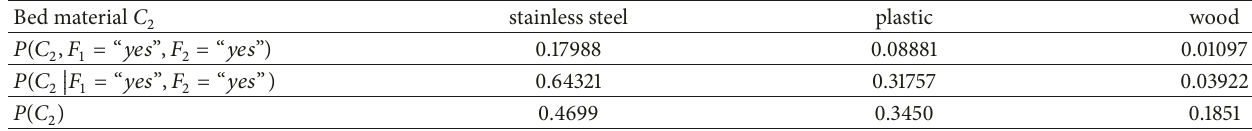
Table 6: The inference conclusions of C 2 .